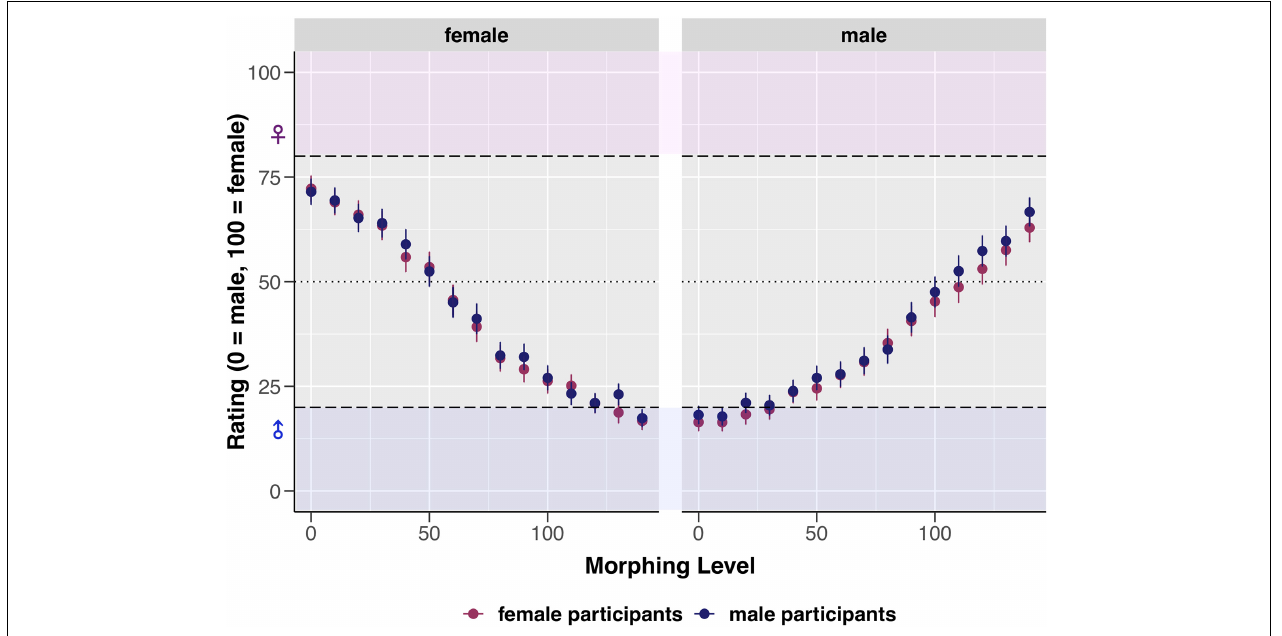
FIGURE 3 | Visualization of the effect of morphing level (0–140) and sex of image (male or female) on the mean ratings. Error bars represent SE. Dashed horizontal lines represent the a priori defined cut-off values (ratings between 0 and 20 = unambiguously male, ratings between 80 and 100 = unambiguously female, and ratings of 50 =